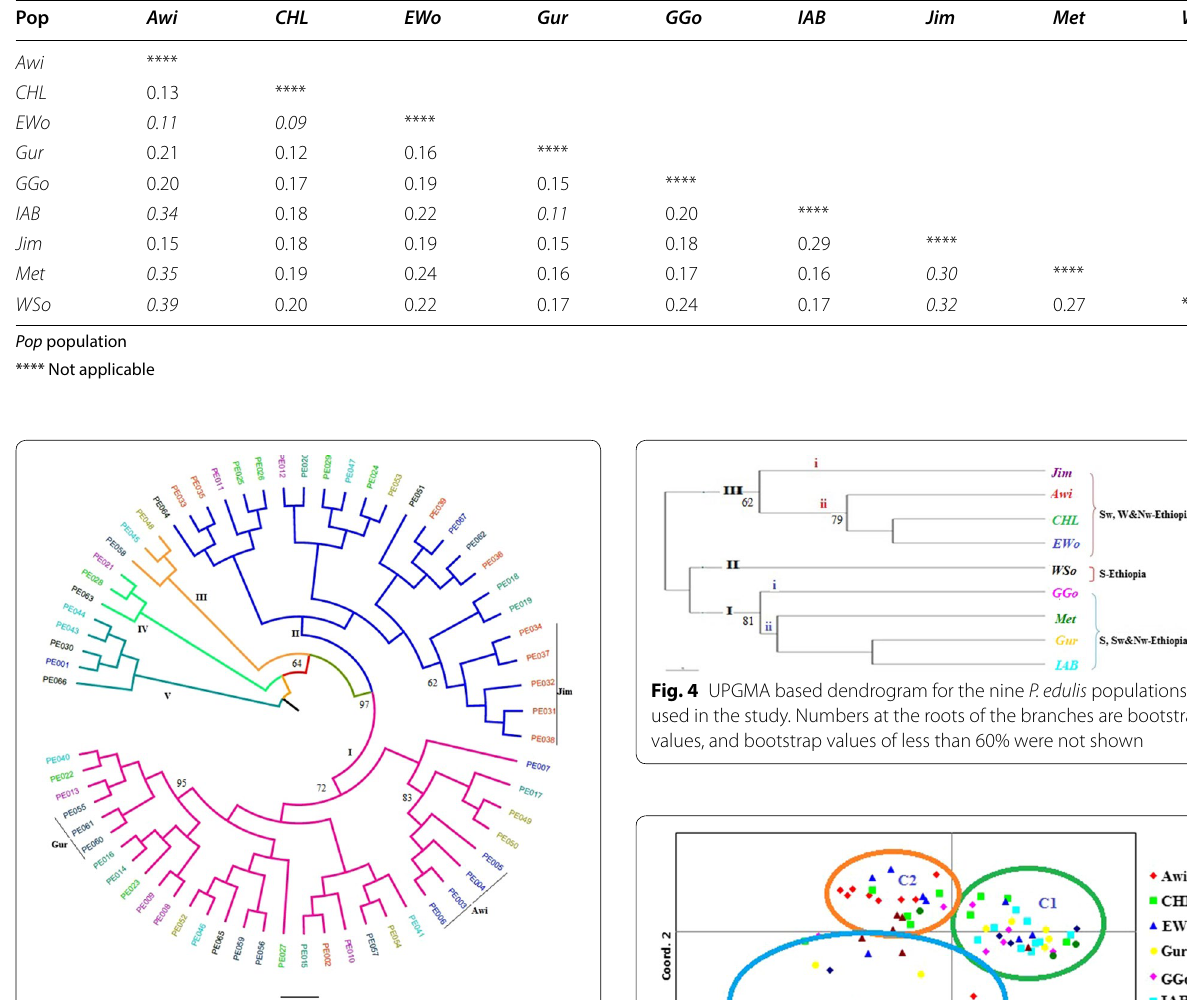
Table 6 Nei’s original measure of pairwise genetic distance for the nine P. edulis populations considered in the study (the italic values stand for the higher and lower pairwise genetic distances)